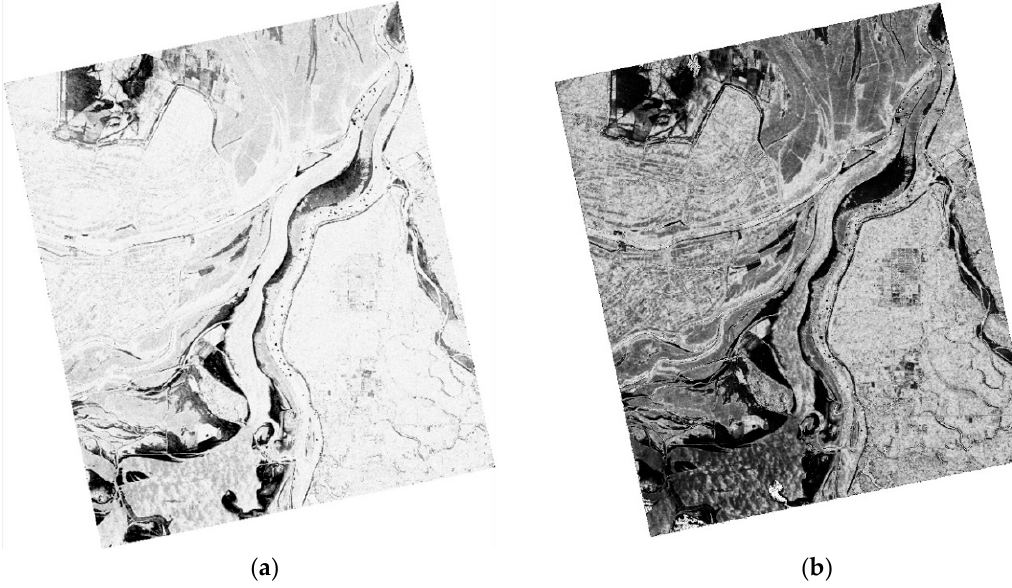
Figure 3. Change detection maps obtained by ( a ) lnQ and ( b ) Polarimetric Difference Image (PDI) Figure3. Changedetectionmapsobtainedby( a )lnQand( b measures.